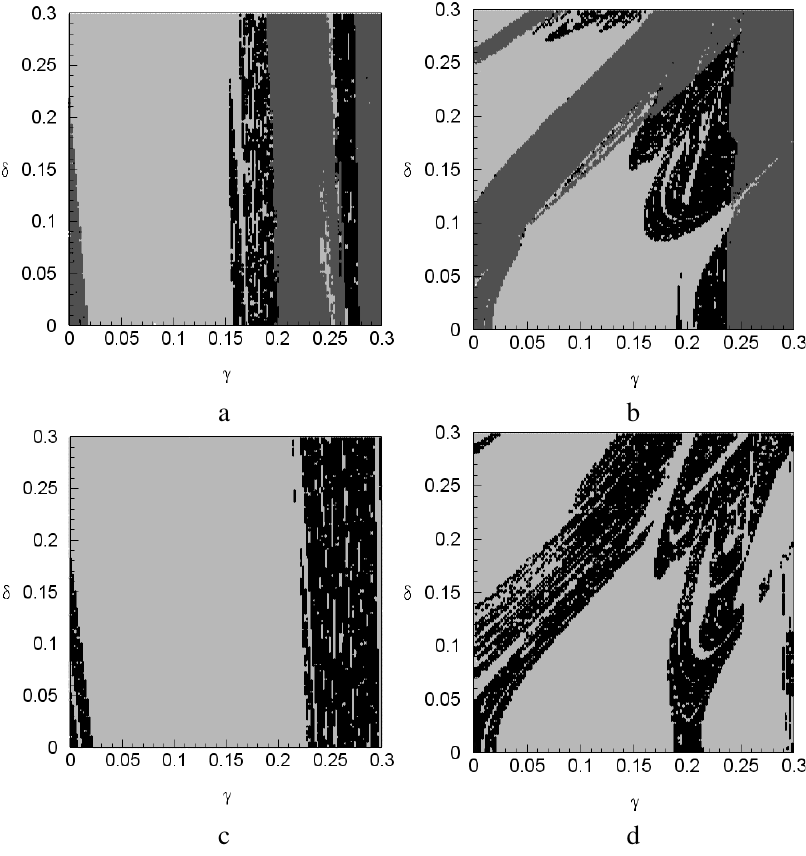
Fig. 1 Maps of dynamical